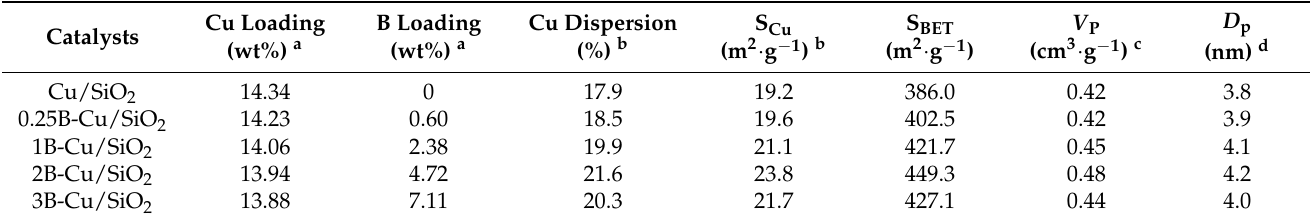
Table 1. Textural properties and chemical compositions of x B-Cu/SiO 2